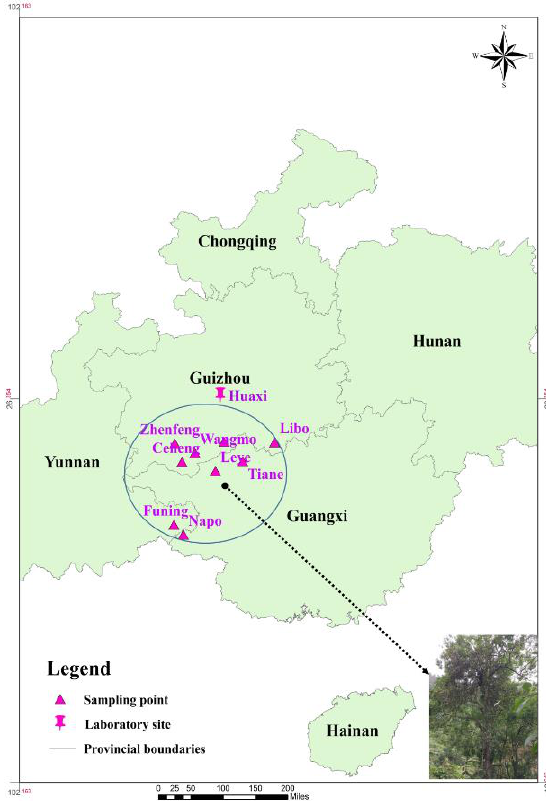
Figure 2. Experimental sites and soil sample collection sites for C. migao in Southwest China.